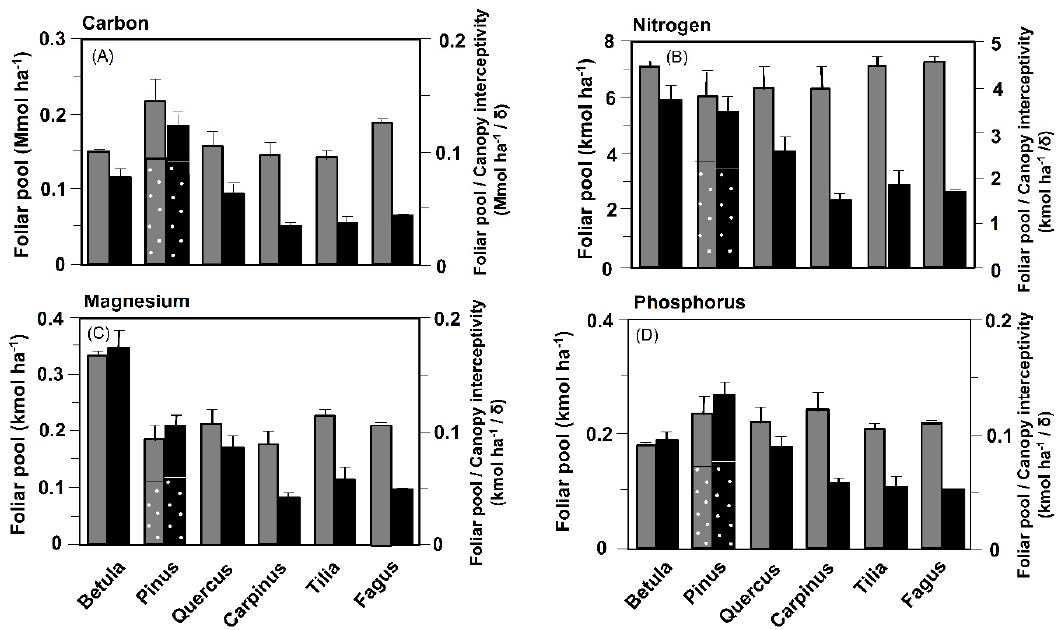
Figure 5. Cost of shade production in terms of leaf biomass in the stands of the six species (means and standard deviation of each 10 litter buckets per stand). Given is the carbon ( A ), nitrogen ( B ), magnesium ( C ) and phosphorus ( D ) investment needed to build the foliage in the stands (grey bars; foliar pool) and the quotient foliar element pool / δ , with δ being the interceptivity factor of the canopy. δ is derived from measured canopy transmissivity for PAR (see text for explanation). The dotted bars mark the current-year needles of Pinus .